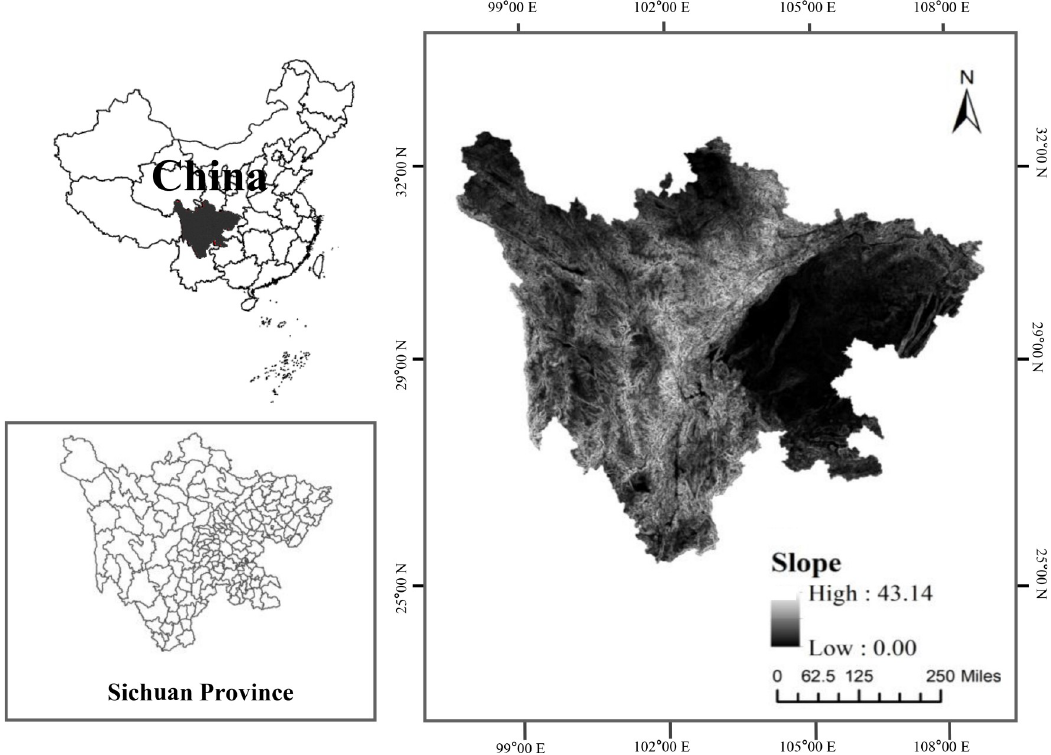
Fig 1. Location of the study area. (Reprinted from [Fig 1] under a CC BY license, with permission from [Resource and Environment Science and Data Center], original copyright [2018]).